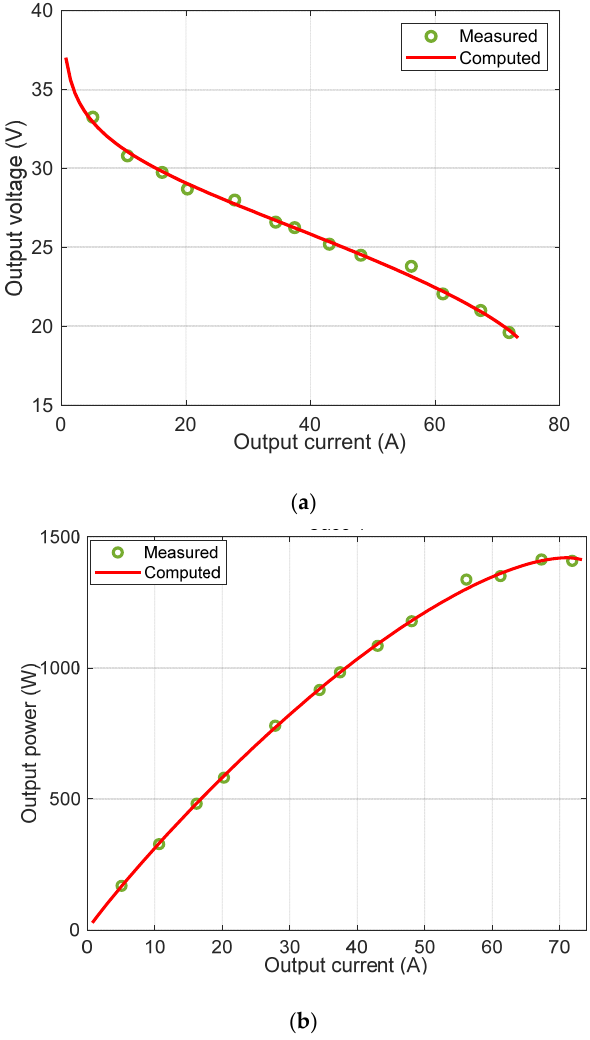
Figure 6. Characteristics of Ballard stack: ( a ) current-voltage and ( b ) current-power.